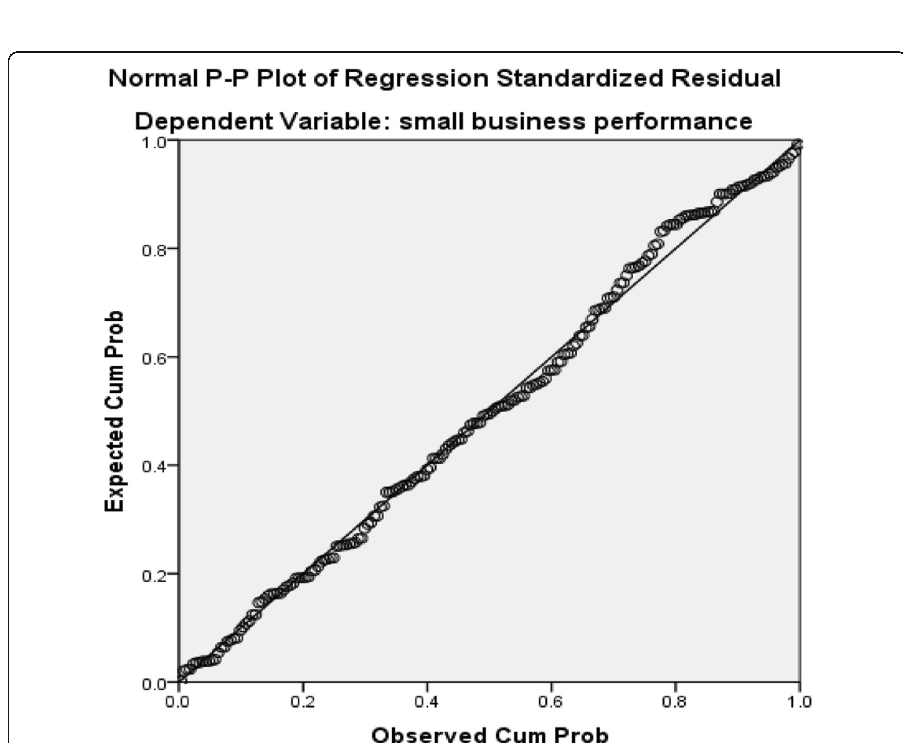
Fig. 3 Normal P-P plot of regression standardized